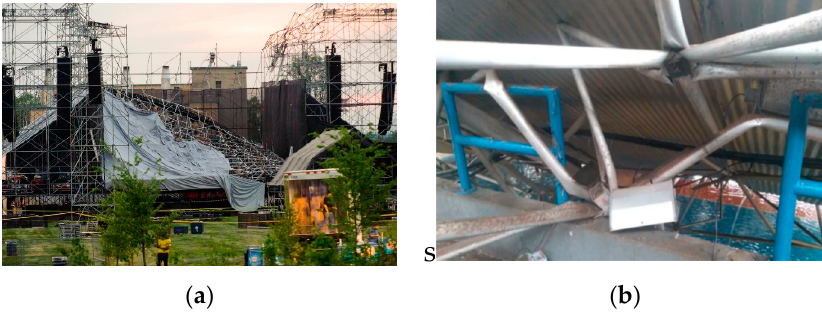
Figure 6. Connection failure and space truss rupture, ( a ) detail of the failure in typical connection at city of Ontario, Canada, ( b ) gymnasium roof collapse, Brazil [60].